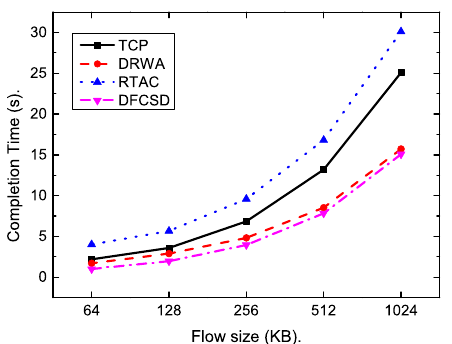
Figure 11. The FCT of the short flow when it competes with a long flow with the size of 10 Mb. The size of the short flow varies from 64 KB to 1024